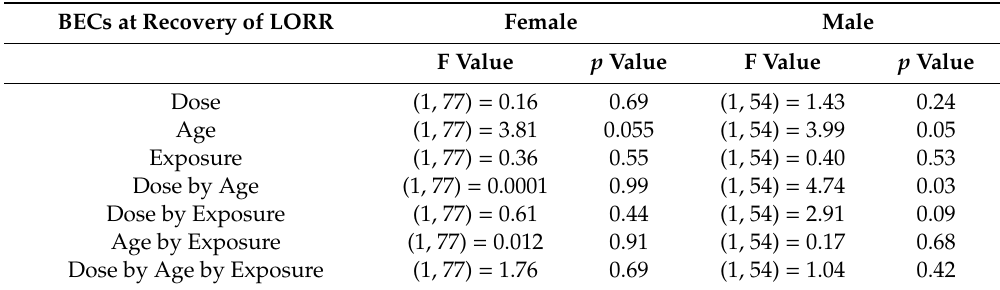
Table 8. Table for ANOVA results for blood ethanol concentrations at recovery of loss of righting reflex data.